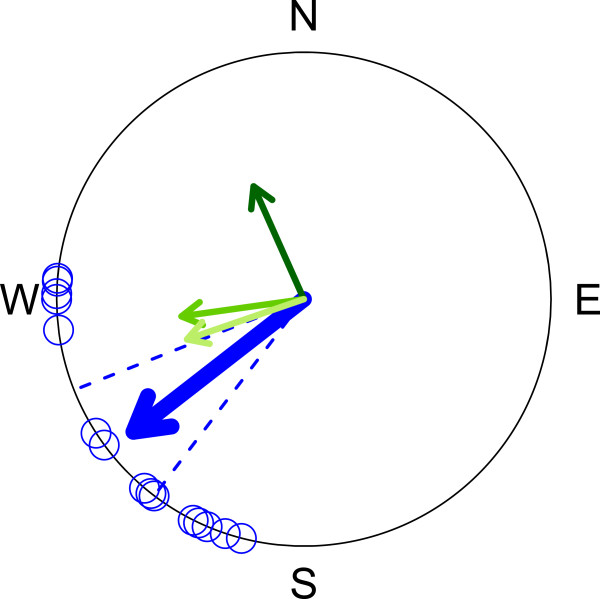
Departure directions of northern wheatears from Wales, Alaska. Departure directions were uniformly distributed towards 233° (Rayleigh test of uniformity: n = 15, R = 0.87, P < 0.0001; 95% CI: 218° – 249°, range: [205°, 288°]). The blue arrow shows the mean departure direction and its length being a measure of scatter is drawn relative to circle’s radius which is one (unit circle). Dashed lines give 95% confidence interval. Equal departure directions were plotted at slightly different directions so that they can be recognized (Table 1). The short arrows indicate the directions of the great circle route (336°, dark green), the constant magnetic course (262°, middle green) and the constant geographic course (251°, light green) from the study site towards Alaskan northern wheatears’ wintering area in sub-Saharan Eastern Africa.